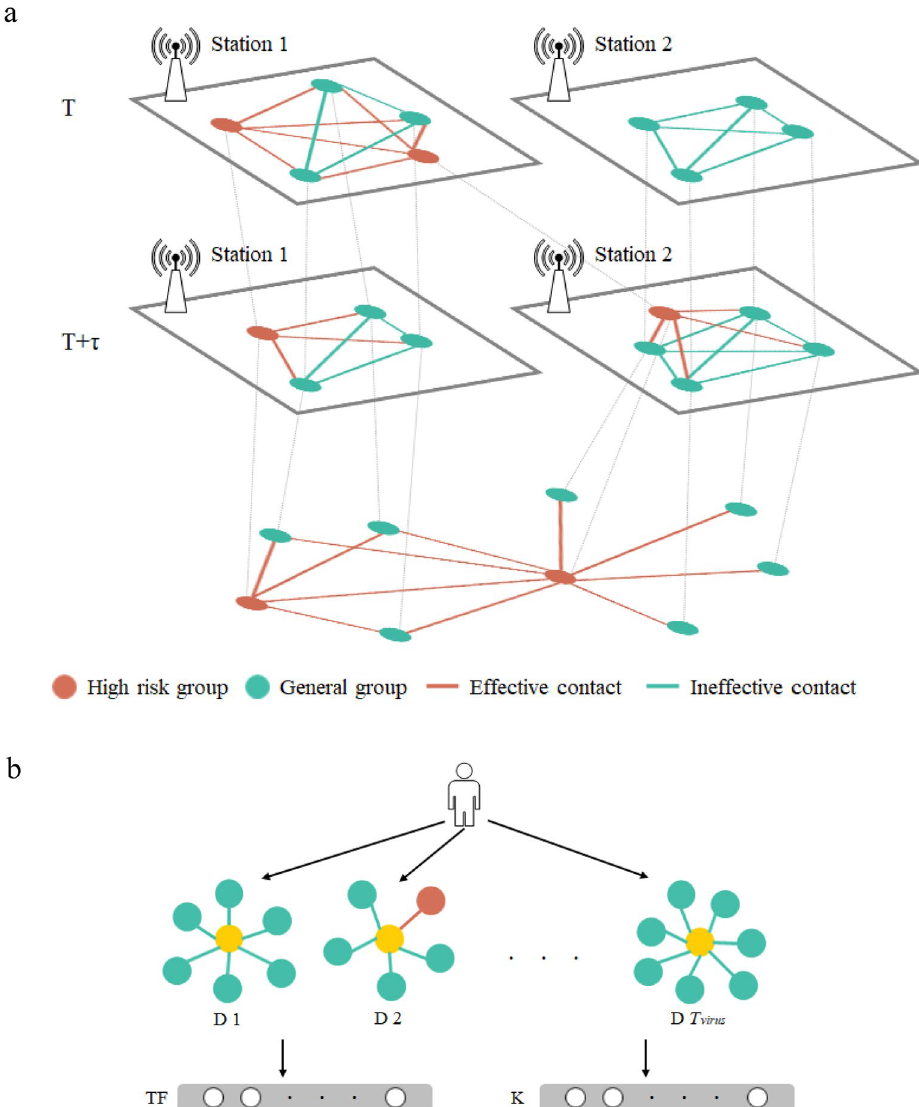
Figure 1. Contact networks structure. ( a ) Schematic diagram of sub-networks and contact network, taking two base stations as an example. Note that this figure only shows the trajectory simulation of two high-risk individuals and seven general individuals during two time slices, but in fact, each contact network is composed of 24 /τ sub-networks of all base stations. ( b ) Visualization of individual-centered contact feature